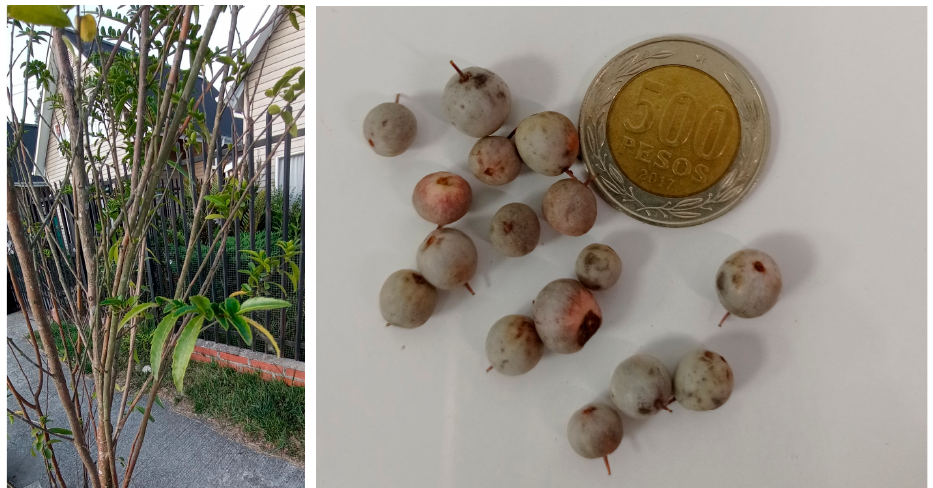
Figure 1. A. dentata plant and fruits from Calera de Tango, Santiago, Metropolitan Region, Chile (coin diameter:26 mm).